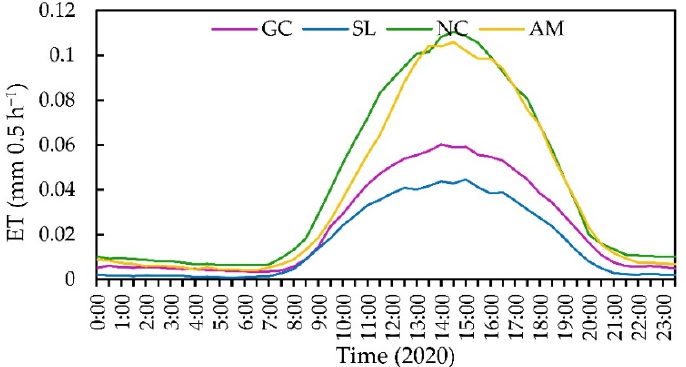
Figure 5. Trends of half-hourly evapotranspiration at the four observation stations in the Qaidam Basin in 2020.